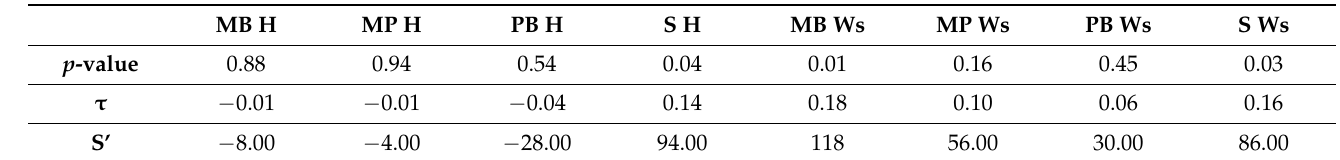
Table 6. Mann–Kendall seasonal test results: the alpha value has been set to 0.05; in bold the significant p-values; average relative humidity ( H ) and average wind speed ( Ws ) at the weather stations ( MB , MP , PB , S ).